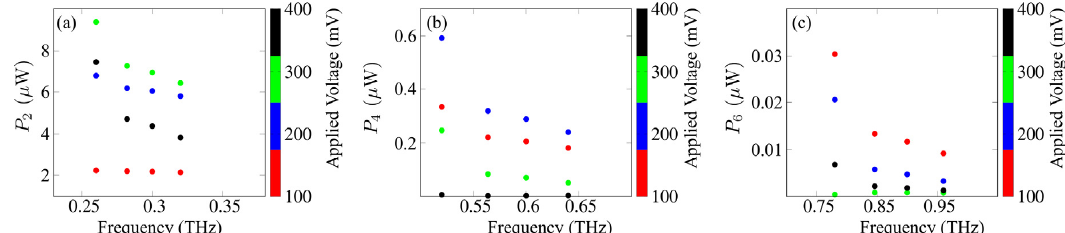
Figure 3. ( a ) Second, ( b ) fourth and ( c ) sixth harmonics output powers for SSL multipliers under the influence of a biased oscillating field for different input BWO devices over frequency ranges 250–950 GHz for a perfectly symmetric current–voltage curve. The input frequencies and powers given respectively by 130, 141, 150, 160 GHz and 61.6, 47, 45.2, 42.2 μ W.